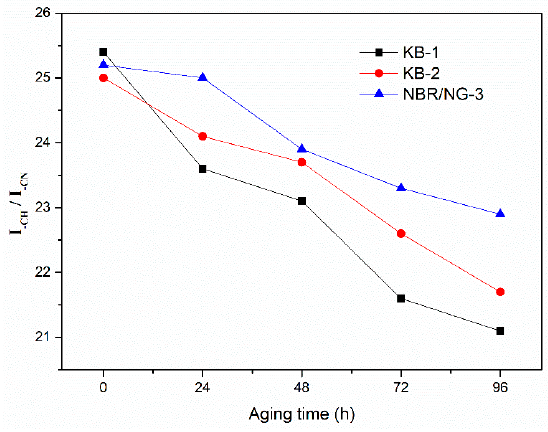
Figure 15. ATR-FTIR spectra of KB-1, KB-2, and NBR / NG-3 at di ff erent aging times.